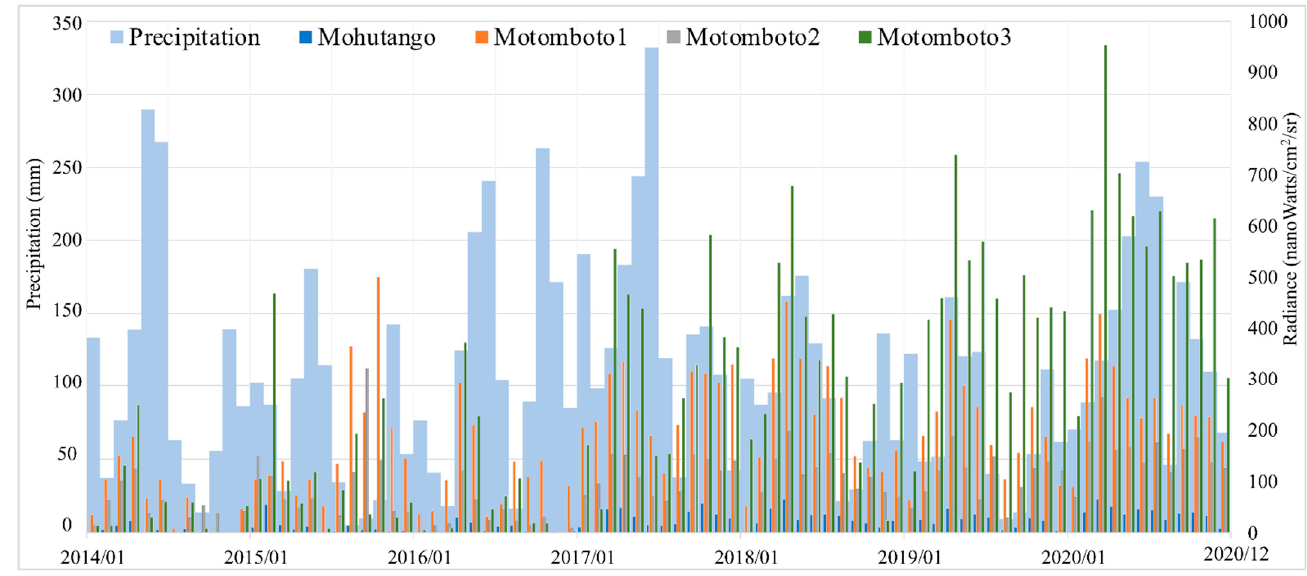
Figure 5. Monthly precipitation (sum) and NTL intensity by mining